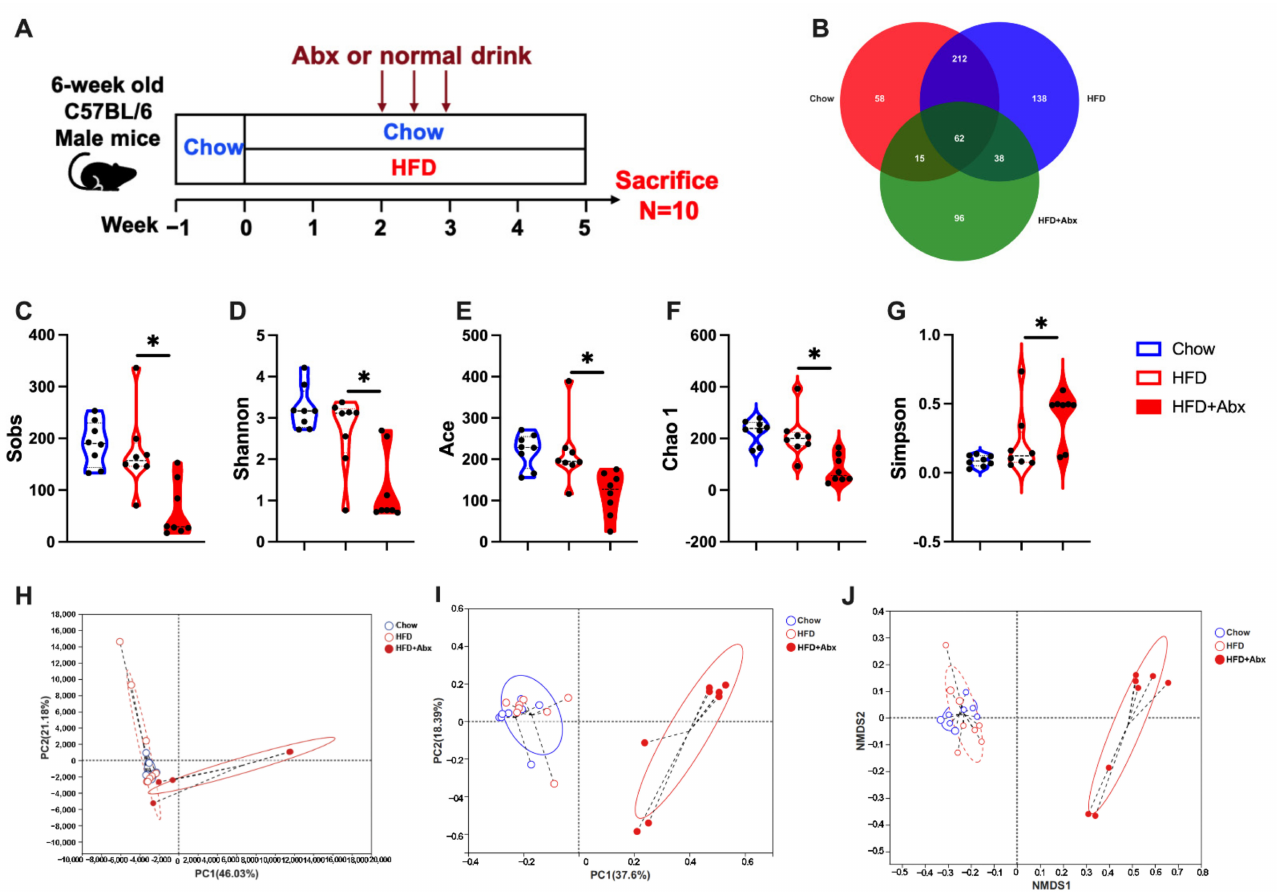
Figure 1. Abx treatment effectively depleted fecal microbiota. ( A ) Experimental design; ( B ) Venn diagram showing the unique and overlapping OTUs presented in Chow, HFD, and HFD+Abx groups; ( C – G ) α -diversity results; ( H – J ) β -diversity with PCA, PCoA, and NMDS score plots for discriminating the colonic microbiota from Chow, HFD, and HFD+Abx groups. * p <